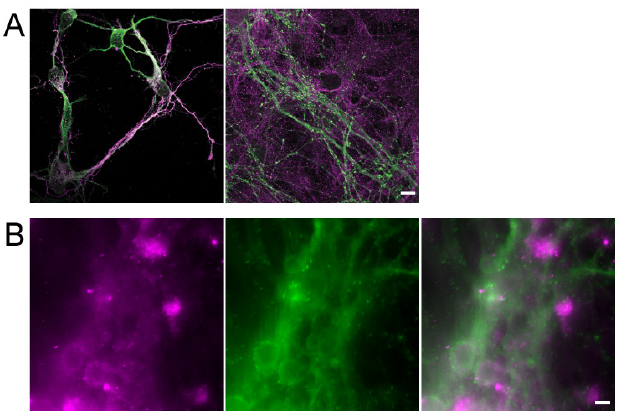
[Figure 1. The characterization and comparison between 2D and 3D cultured hippocampal neurons. ( A ) Images of neurons cultured on 2D coverslips. (Left) early stage markers, Tau (magenta) and microtubule-associated protein 2 (MAP2) (green) are used to labeled axon and dendrites, respectively, at 4 days in vitro (DIV). (Right) mature neurons at 15 DIV were labeled with markers for synapse formation, Synaptotagmin 1 (magenta) for presynaptic terminals and postsynaptic density protein 95 (PSD-95) (green) for postsynaptic. Scale bar: 10 μ m. ( B ) The differentiation of 3D cultured neurons was visualized by staining with the neuronal markers, Tau (magenta) and MAP2 (green) at 15 DIV. Scale bar: 10 μ m.